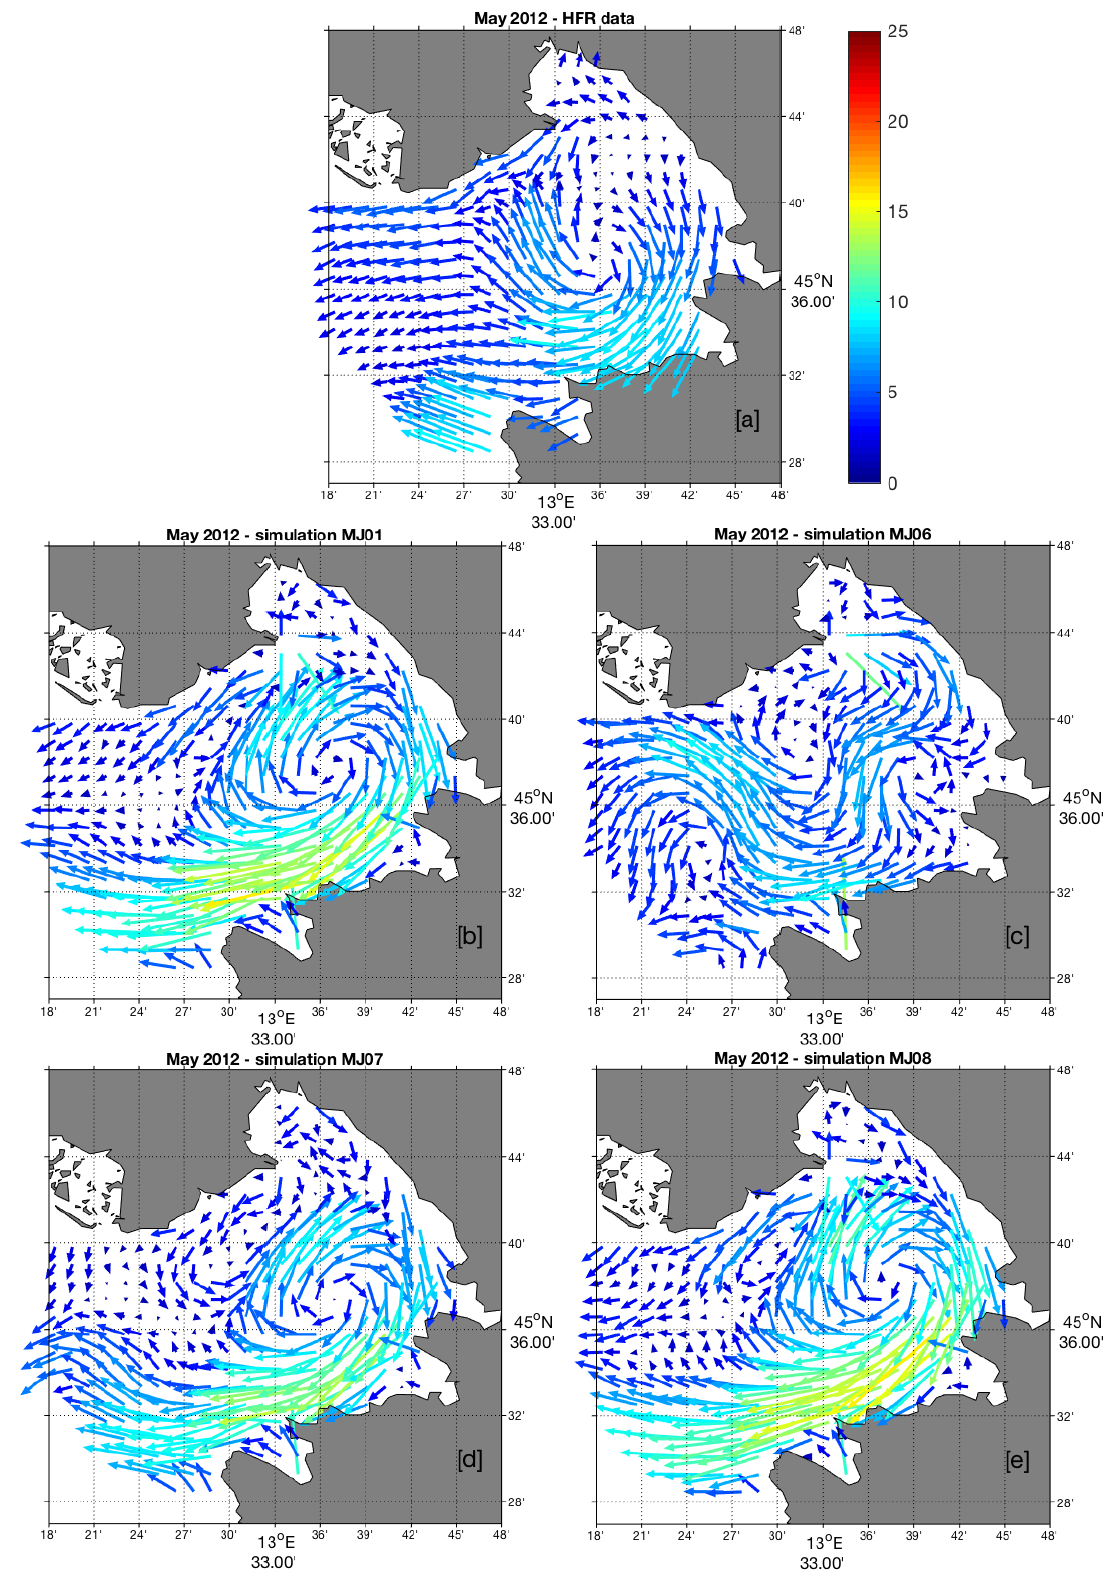
Figure 8. Monthly mean surface currents in May 2012 derived from ( a ) HF radar data, ( b ) numerical simulation in its full configuration (RR) and numerical simulation without ( c ) wind forcing (NW), ( d ) river input (NR) and ( e ) tidal forcing (NT). Units are